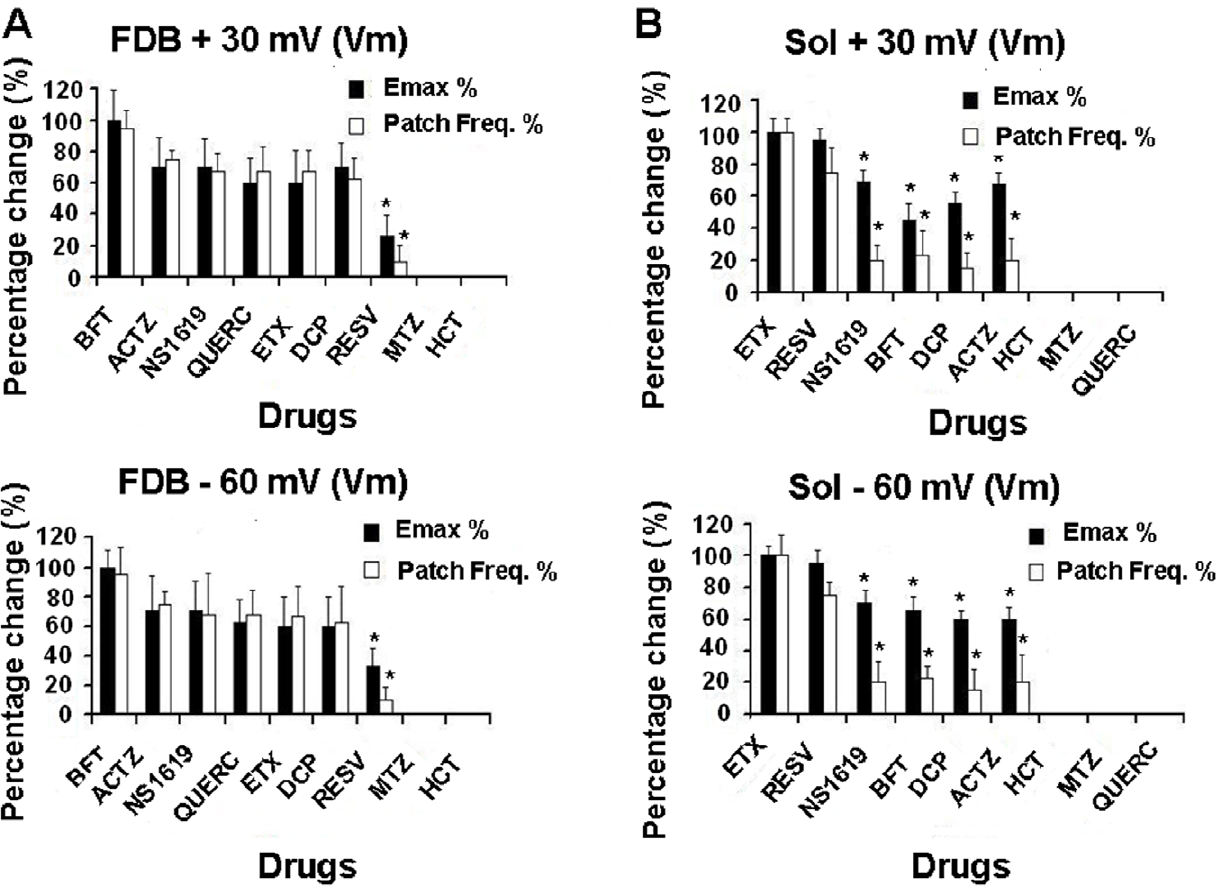
Figure 5. Frequency distribution (Patch freq.%) of patches containing Ca 2 + activated K + (BK) channels drug sensitive and the maximal drug effect (Emax%) at different voltages. Drug response was evaluated at 2x10 2 4 M concentration in excised patch experiments at 2 60 mV and + 30 mV (Vm) with 150 mM KCl on both side of the membrane patches, and in the presence of 10 2 5 M Ca 2 + ions concentrations in the bath. (A) An higher frequency of finding patches containing BK channels responders to bendroflumethiazide (BFT), acetazolamide (ACTZ), benzimidazolone (NS1619), quercetin (QUERC), ethoxzolamide (ETX), dichlorphenamide (DCP) was found in flexor digitorum brevis (FDB) fibers with respect to soleus (Sol) fibers at both voltages. A low frequency was calculated for resveratrol (RESV) in the same muscle fibers, while methazolamide (MTZ) and hydrochlorthiazide (HCT) were not effective. The data were expressed as means 6 E.S. Data (*) were significantly different for P , 0.05 in comparison to BFT data. (B) An higher frequency of finding patches containing BK channels responders to ETX and RESV was found in Sol fibers as compared with FDB fibers, but a low frequency of finding BK channels responders to ACTZ, NS1619, ETX, and DCP was found in these fibers. HCT, MTZ and QUERC were not effective in Sol fibers. Data (*) were significantly different for P , 0.05 in comparison to ETX and RESV